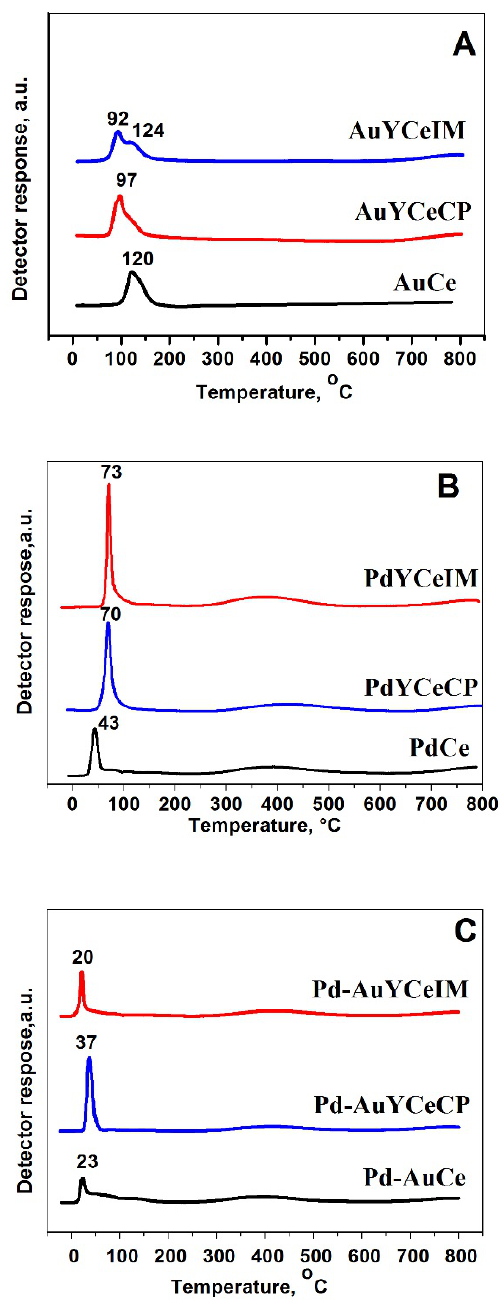
Figure 4. TPR profiles of monometallic Au ( A ), monometallic Pd ( B ) and bimetallic Pd–Au catalysts ( C ) on ceria and Y-doped ceria supports.